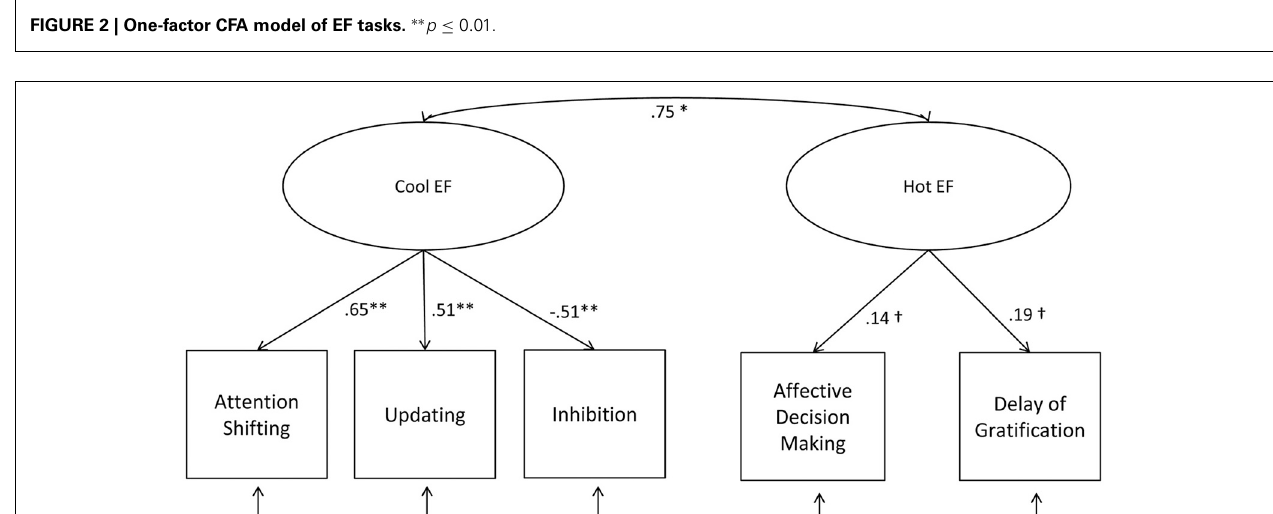
FIGURE 2 | One-factor CFA model of EF tasks. ∗∗ p ≤ 0 . 01.